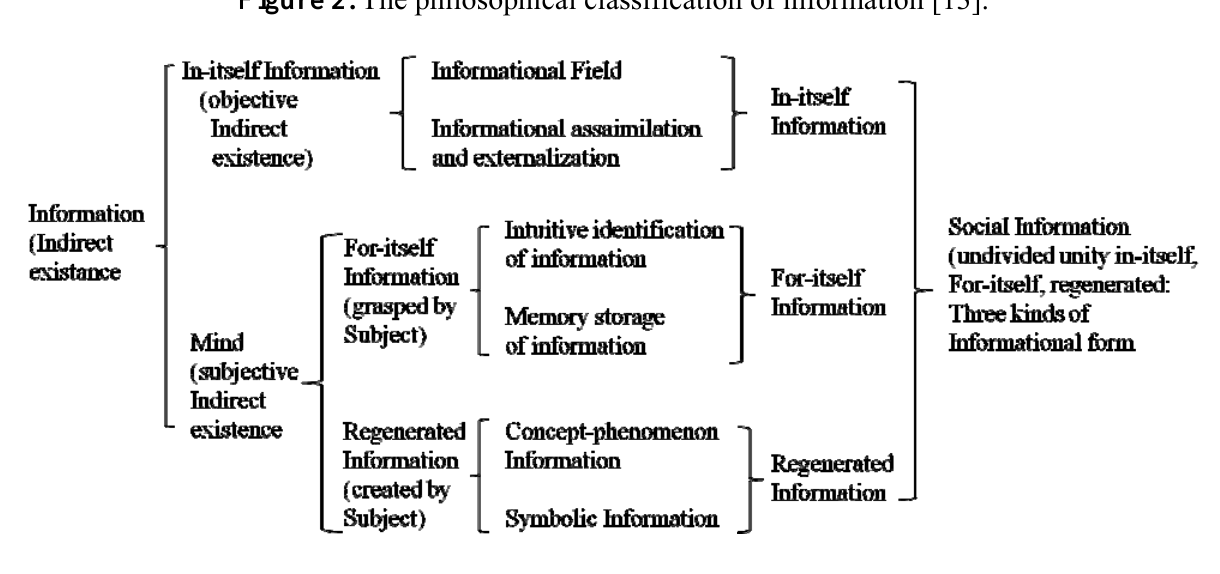
Figure 2. The philosophical classification of information